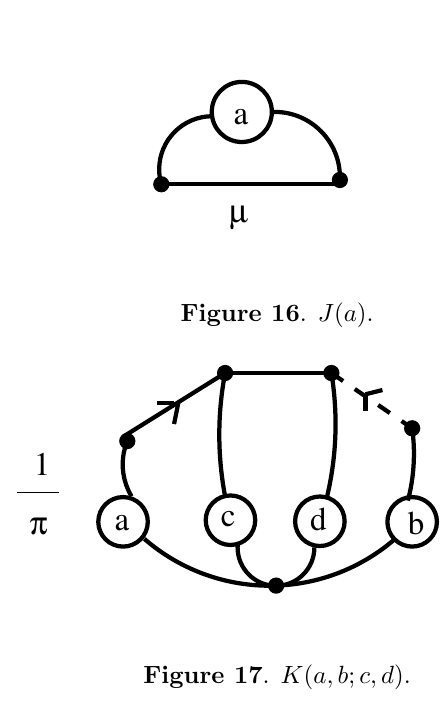
Figure 17 . K ( a; b ; c; d